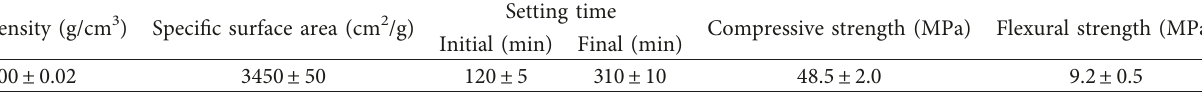
Table 1: Physical and mechanical properties of P.O. 42.5 Portland cement.